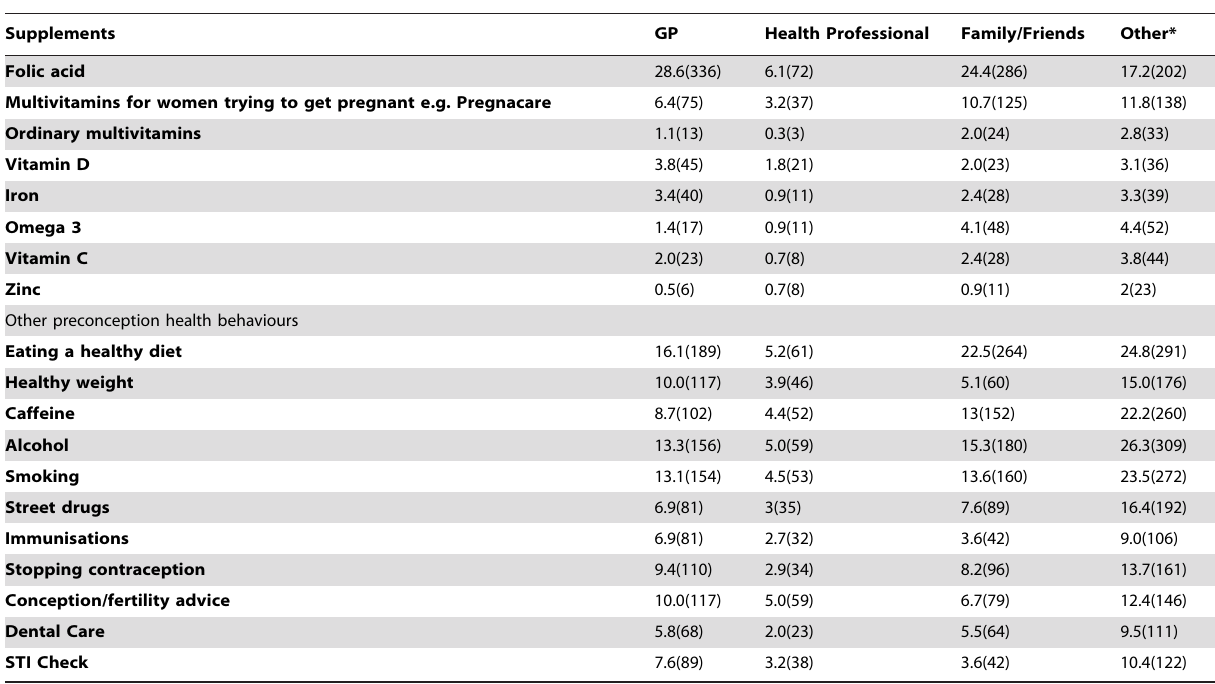
Table 3. Source of advice on supplements and health behaviours received before